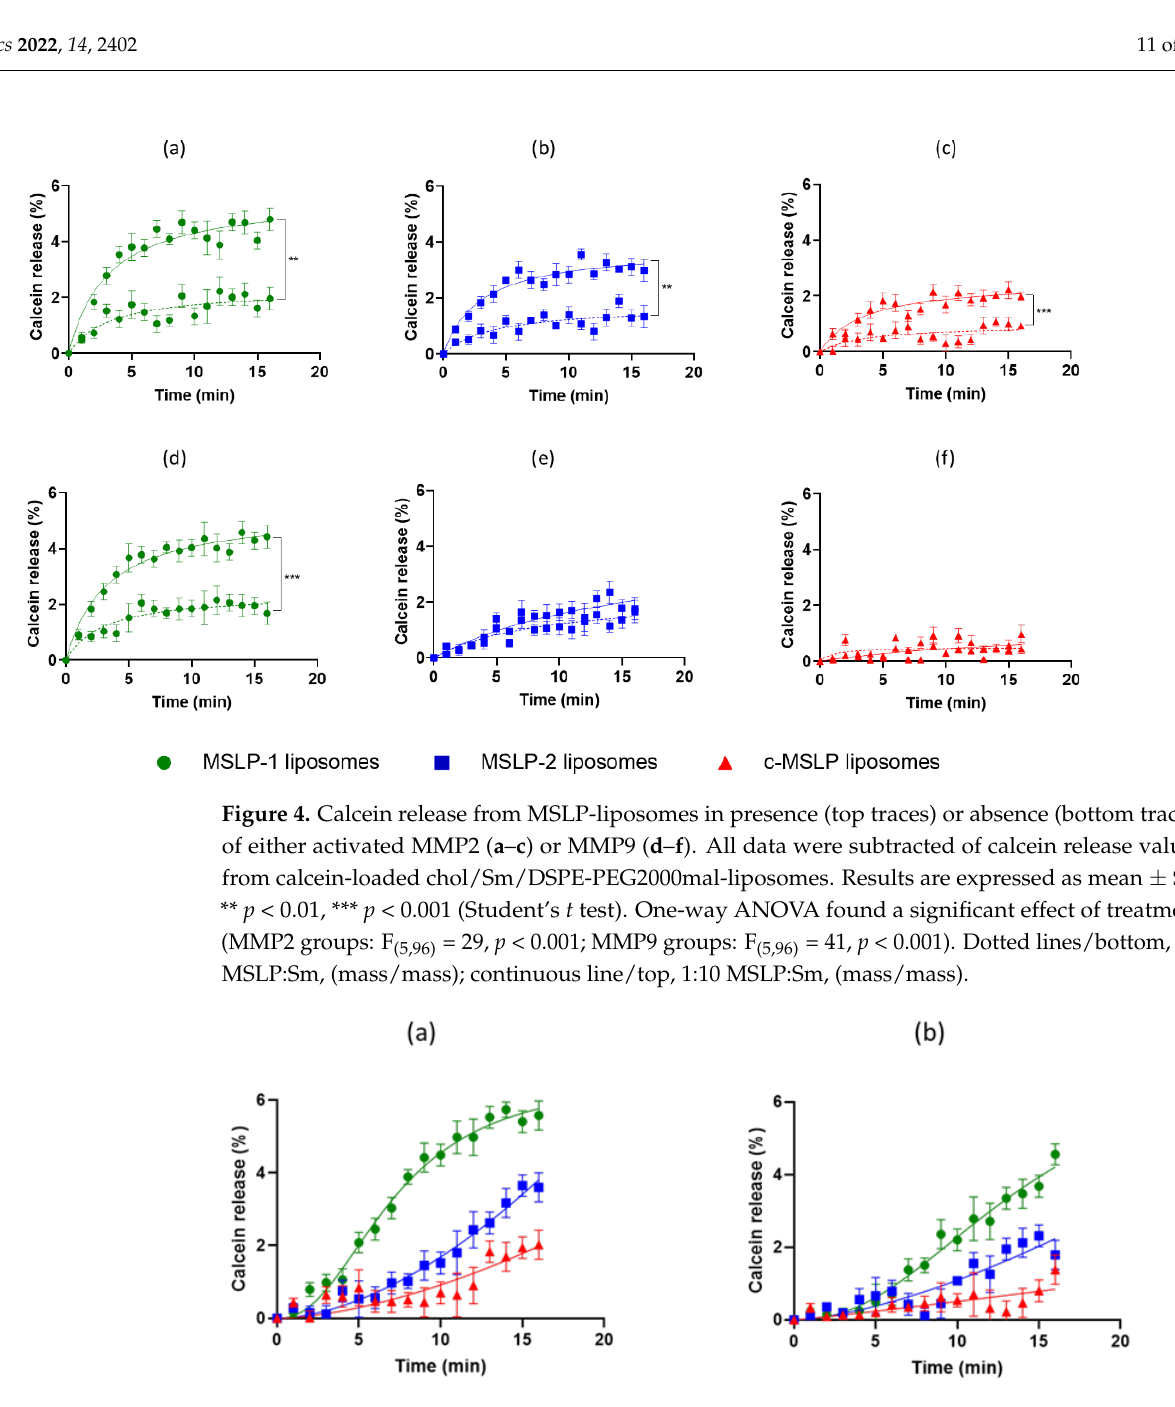
Figure 5. Calcein release from mApoE-MSLP-liposomes (1:10 MSLP:Sm, mass/mass) in presence of activated ( a ) MMP2 or ( b ) MMP9. Curves were subtracted of calcein release values from calcein-loaded chol/Sm/DSPE-PEG2000mal-liposomes. Results are expressed as mean ± SD. One-way ANOVA found a significant effect of treatment (MMP2: F (5,96) = 5.6, p = 0.0001; MMP9: F (5,94) = 6.7, p < 0.001).